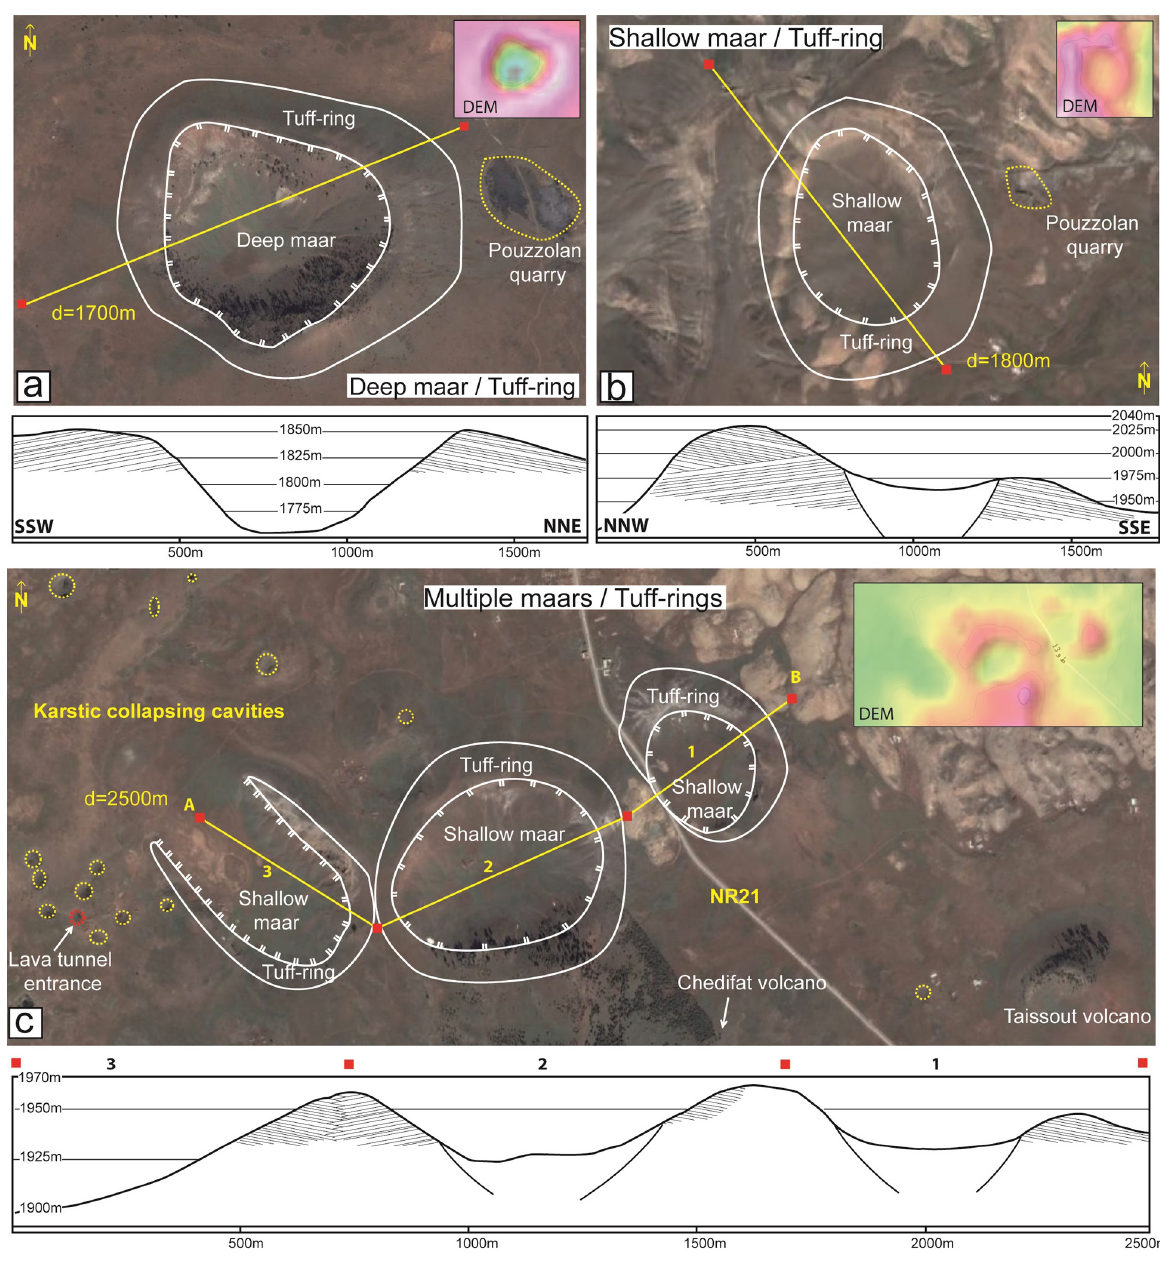
Fig. 6. Morphology, shape, and crater outlines of maars surrounded by tuff-rings sketched on Google satellite images jointed to the digital elevation overview and the cross-section sketch. DEM – Digital Elevation Model; NR21 – national roadway no. 21. a) Deep maar of Lechmine N’ait l Haj. b) The elongated shallow maar of Cheker